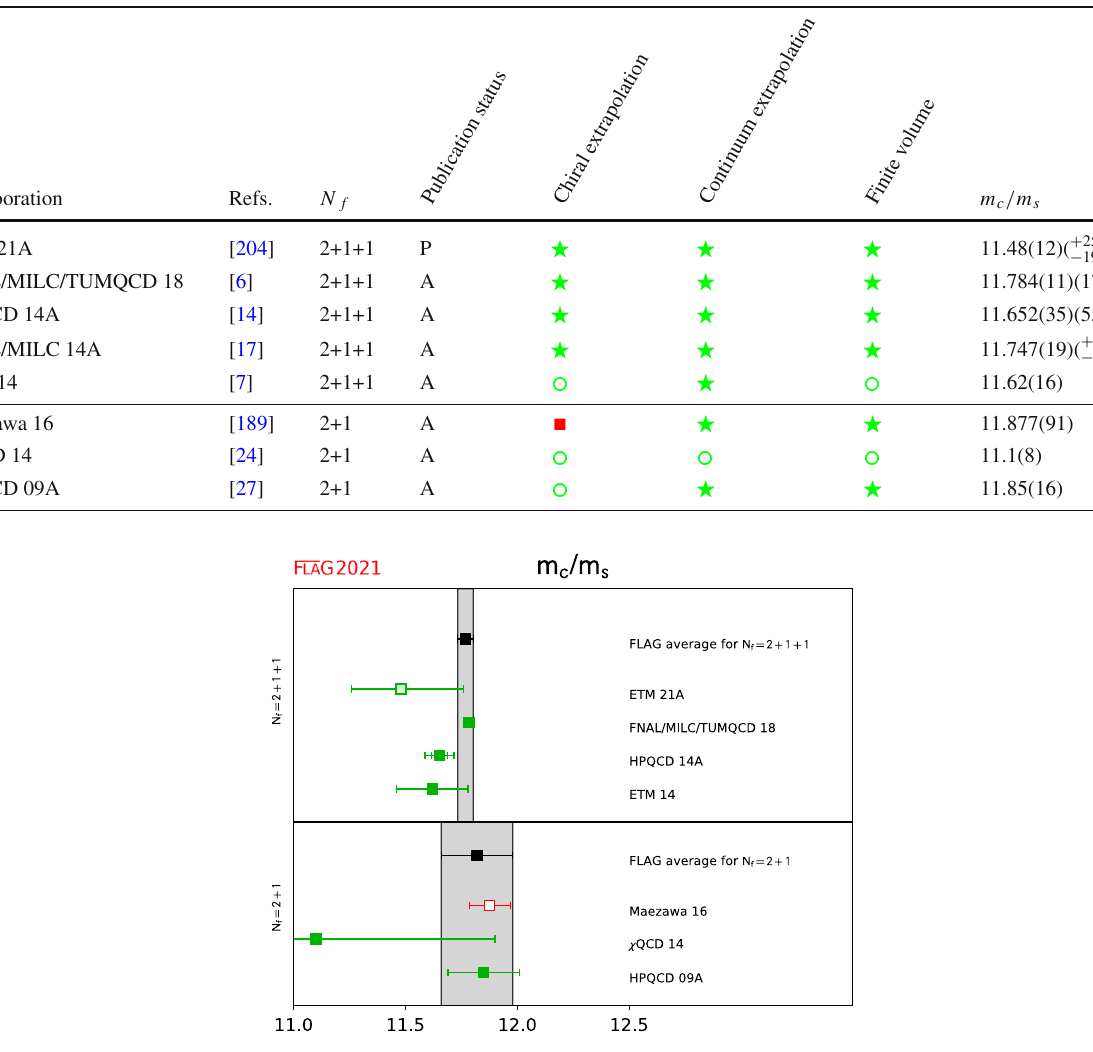
Fig. 6 Lattice results for the ratio m c / m s listed in Table 13 and the FLAG averages corresponding to 2 + 1 and 2 + 1 + 1 quark flavours. The latter average includes a large stretching factor on the error due a poor χ 2 from our